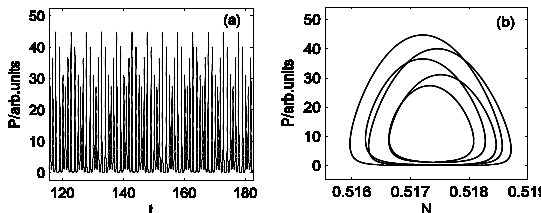
Fig. 6. A cycle-5. (a) a cycle-5 movement. (b) a cycle-5 orbit.